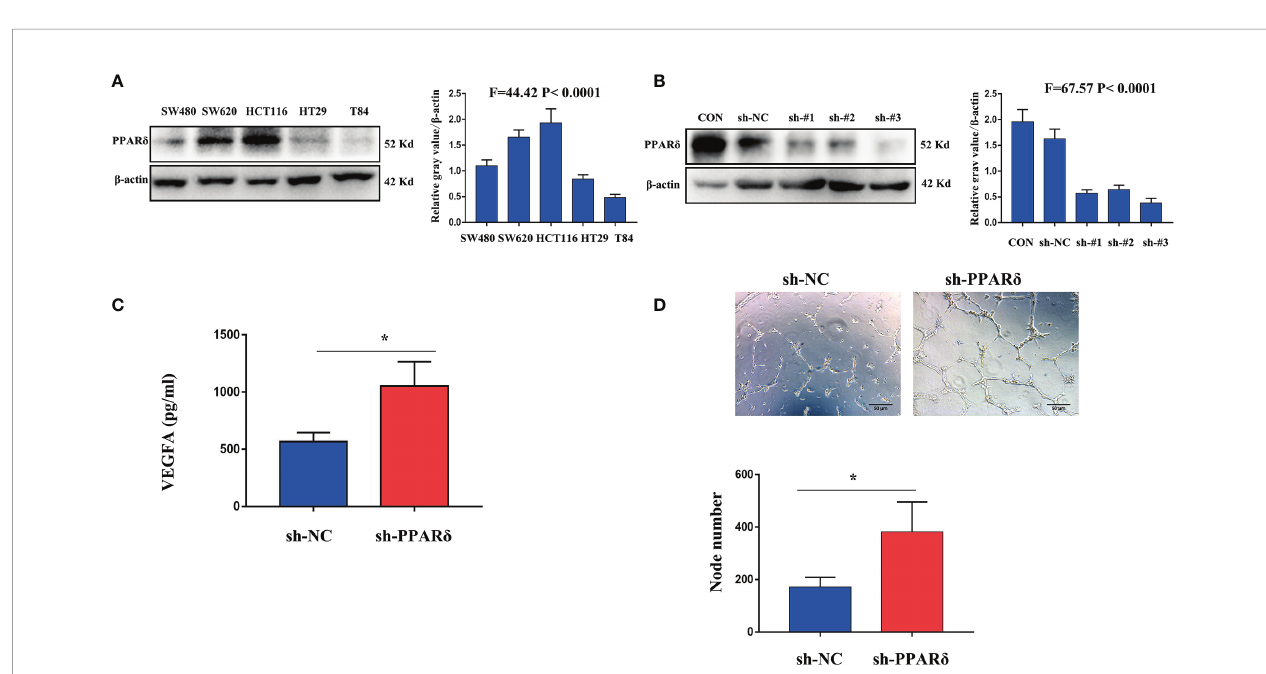
FIGURE 1 | PPAR d expression is inversely correlated with angiogenesis in human CRC tissues. (A) Immunohistochemical staining of PPAR d protein in tumor tissues and paired normal tissues were evaluated (scale: 200 m m). (B) PPAR d expression level and MVD (CD31-positive cells) in tumor tissues (scale: 200 m m). (C) The correlation between the expression of PPAR d and MVD in 120 CRC patients was analyzed (P = 0.0002). Data represent the mean ±